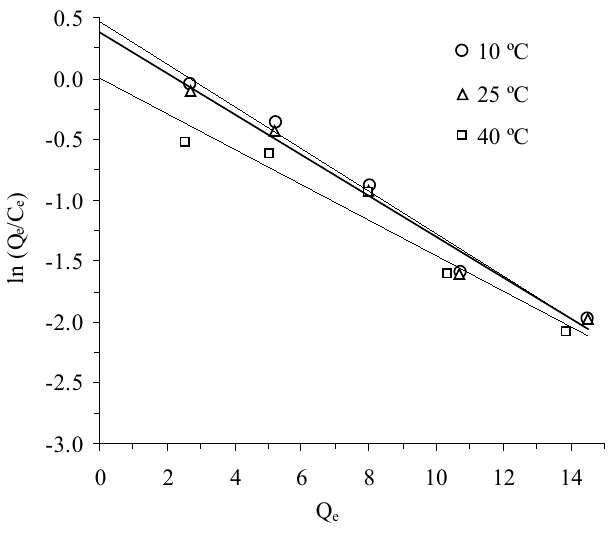
Figure 3. Plots of ln (Q thermodynamic equilibrium constants by using the method of Khan and Singh [46].